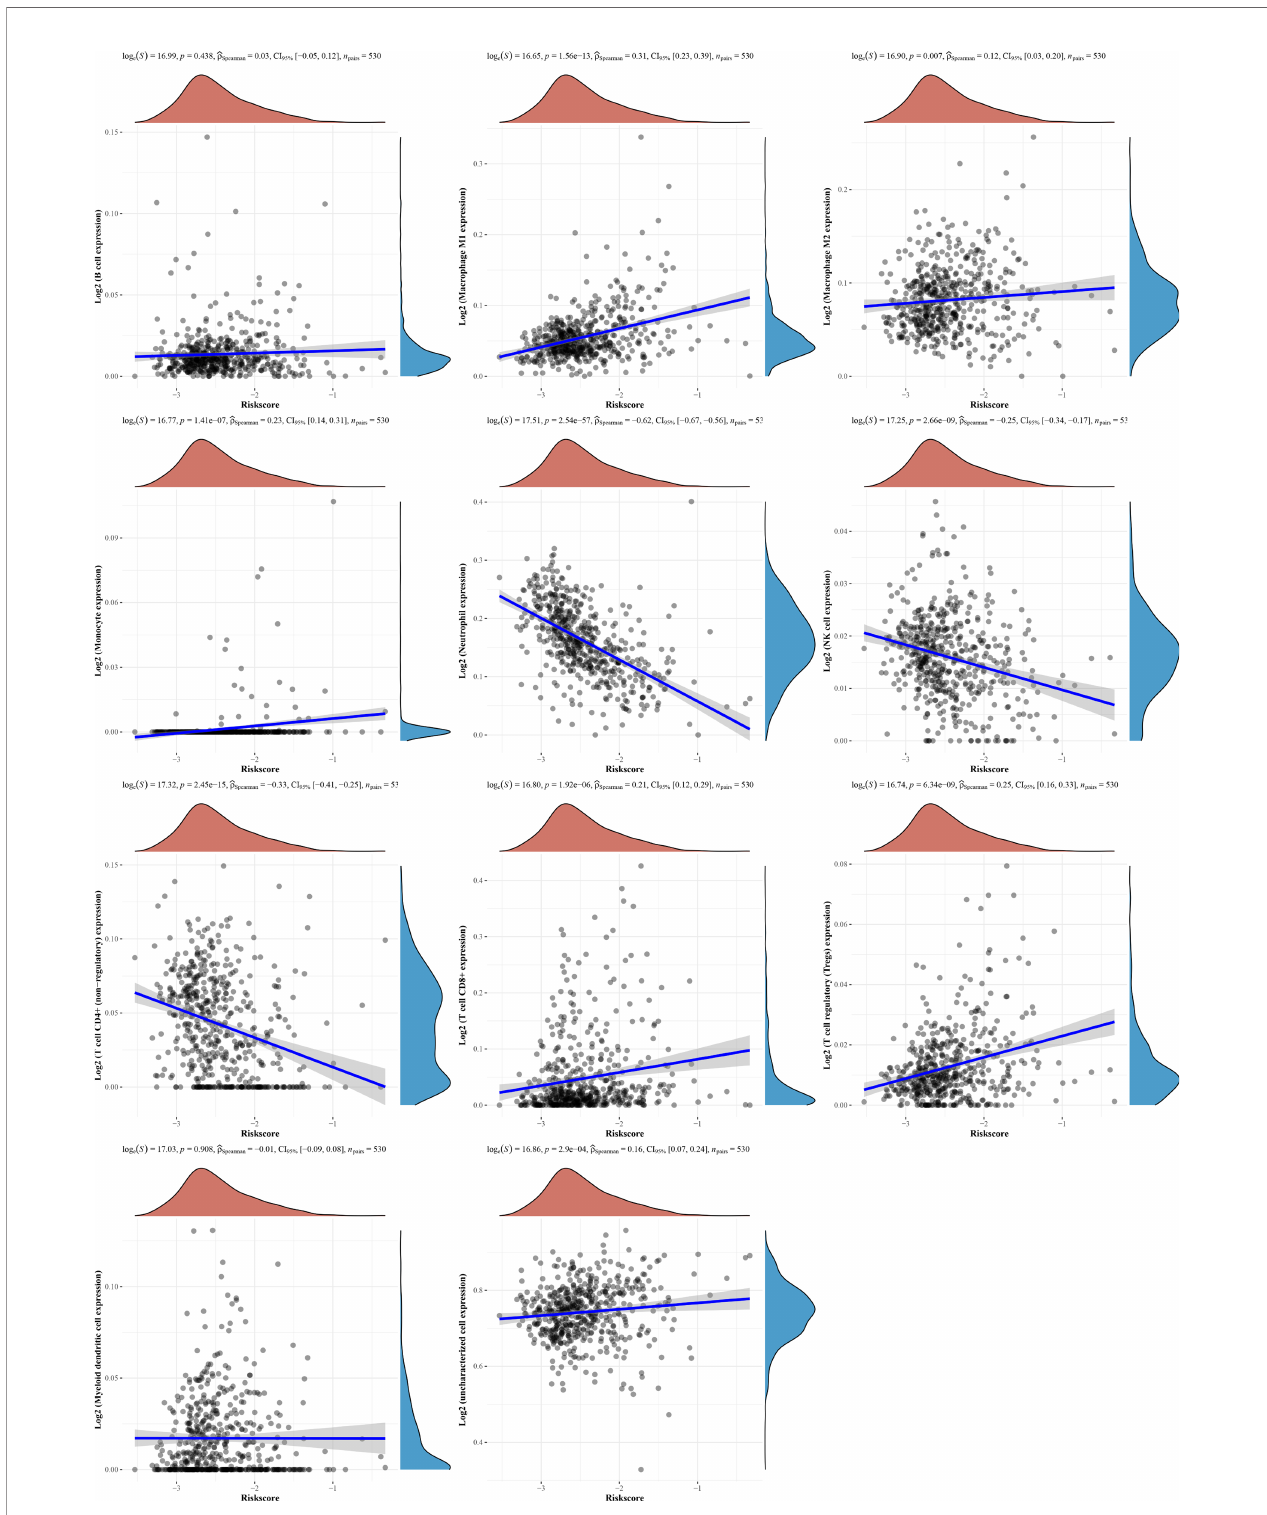
FIGURE 8 | Evaluation of the TME between the two groups using the